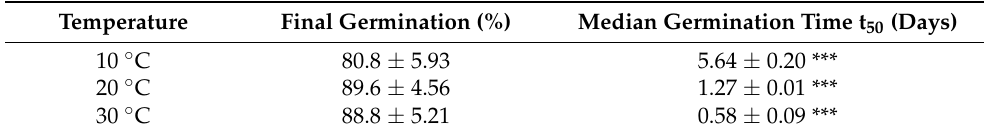
Values are expressed as mean ± SD of five independent replicates. Statistical analysis was performed using Kruskal-Wallis ( p < 0.001) followed by a Dunn’s test multiple comparison test. Asterisks indicate significant differences between treatments (*** p <